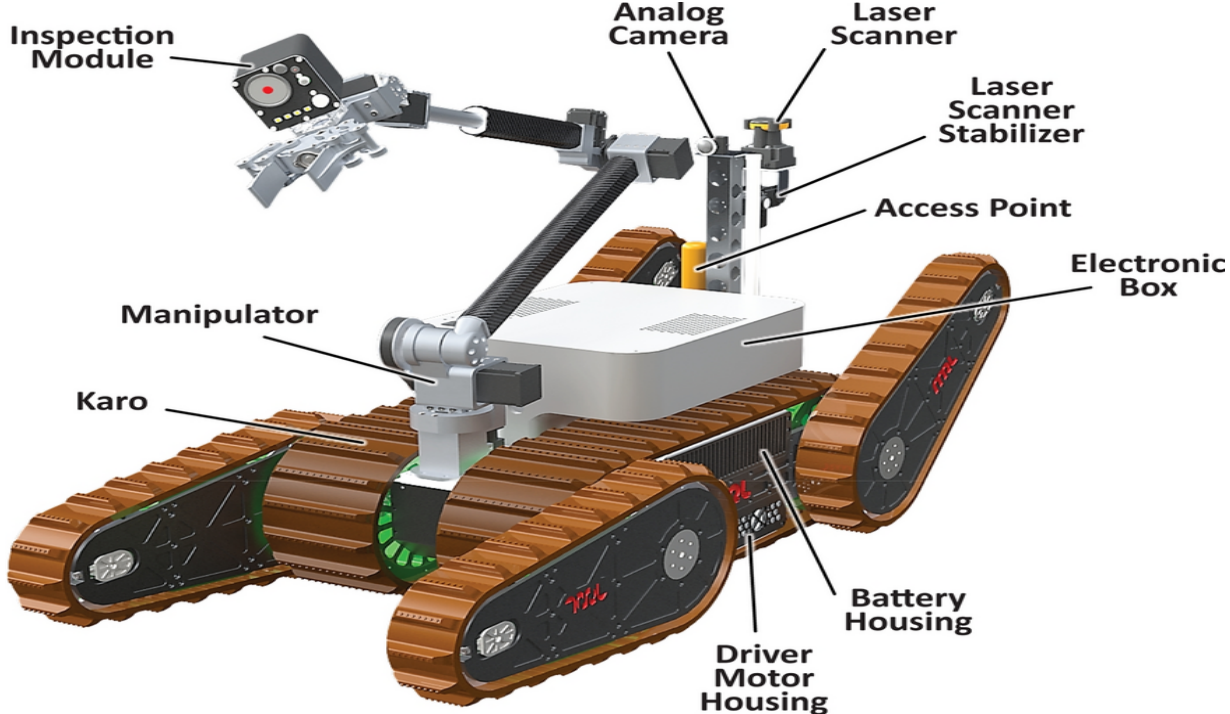
Figure 13. 3D model of the mobile robot (Karo) [87].